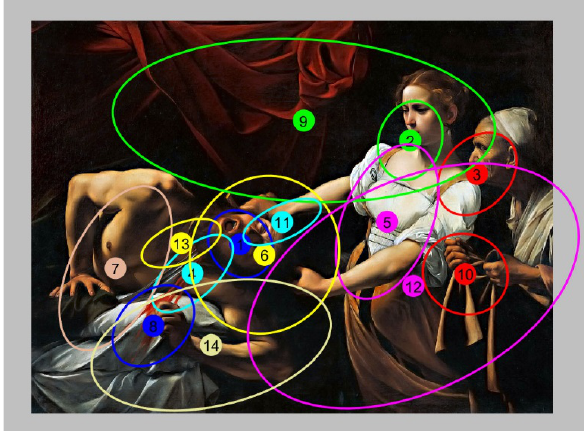
Figure 6. Ellipses for 14 clusters in P2